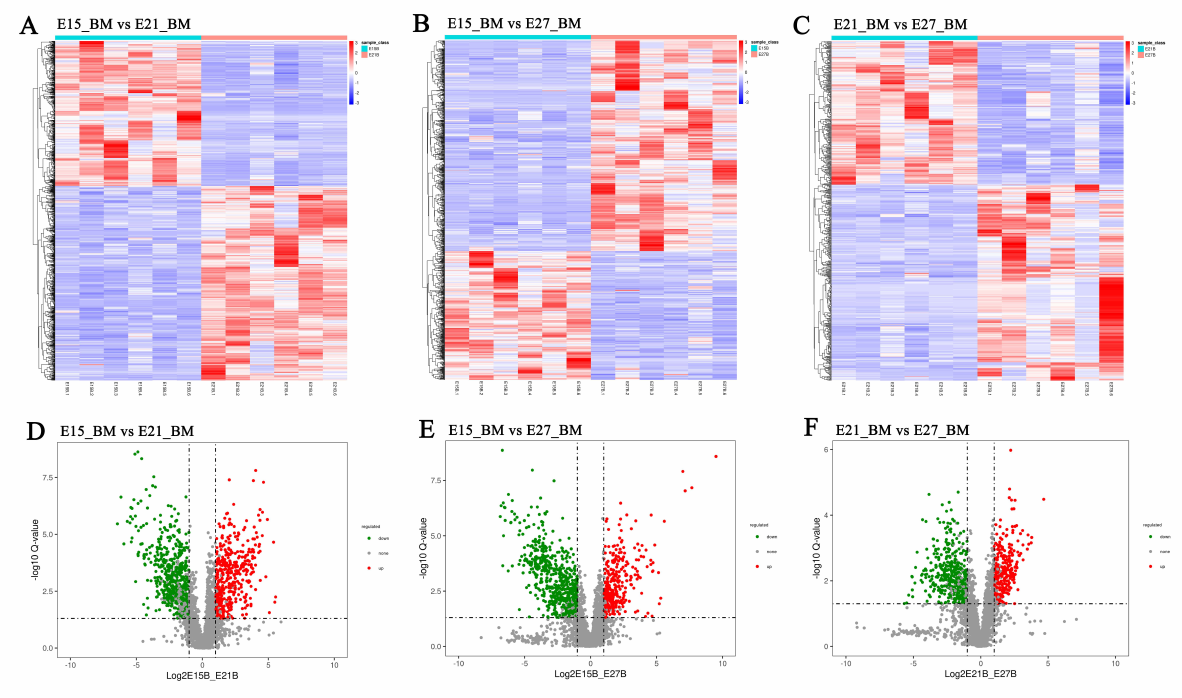
Figure 3. Identification of differentially accumulated metabolites among three comparison groups.